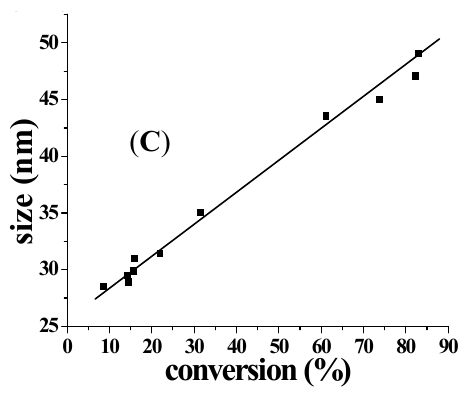
Figure 9. Evolution of particle size measured by DLS at 25 ◦ C versus time or conversion for RAFT-mediated aqueous polymerization. Polymerization conditions: ( A ) macro-RAFT agent:[TFEMA] = 1:700, macro-RAFT agent:[APS] = 9:1, [EGDMA]:[TFEMA] = 5:100, 70 ◦ C; ( B ) macro-RAFT agent:[TFEMA] = 1:700, macro-RAFT